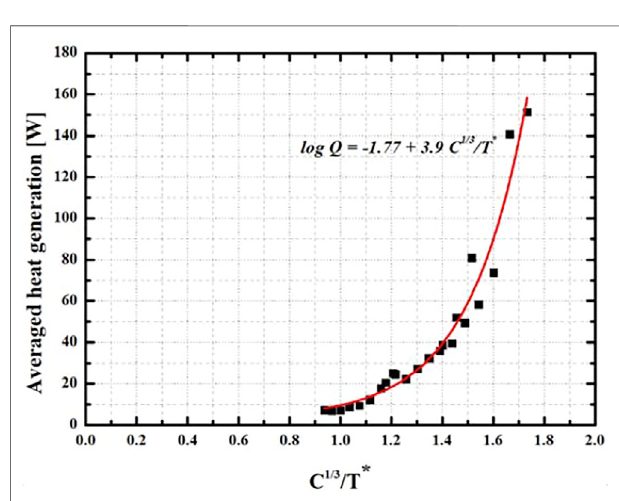
FIGURE 5 | Averaged heat generation on the surface of the battery.